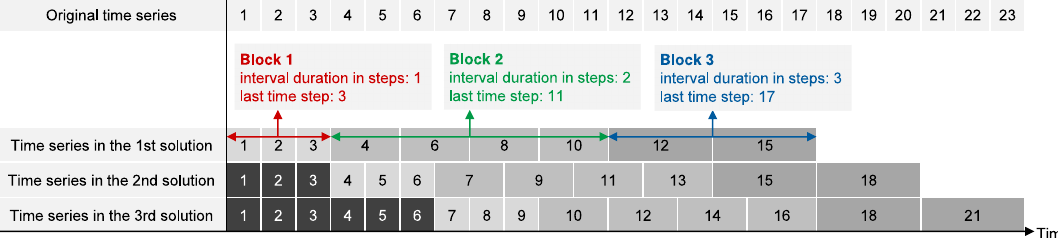
Figure 2. Temporal structure. Decisions in the intervals shown with a black background have been realized already in the previous